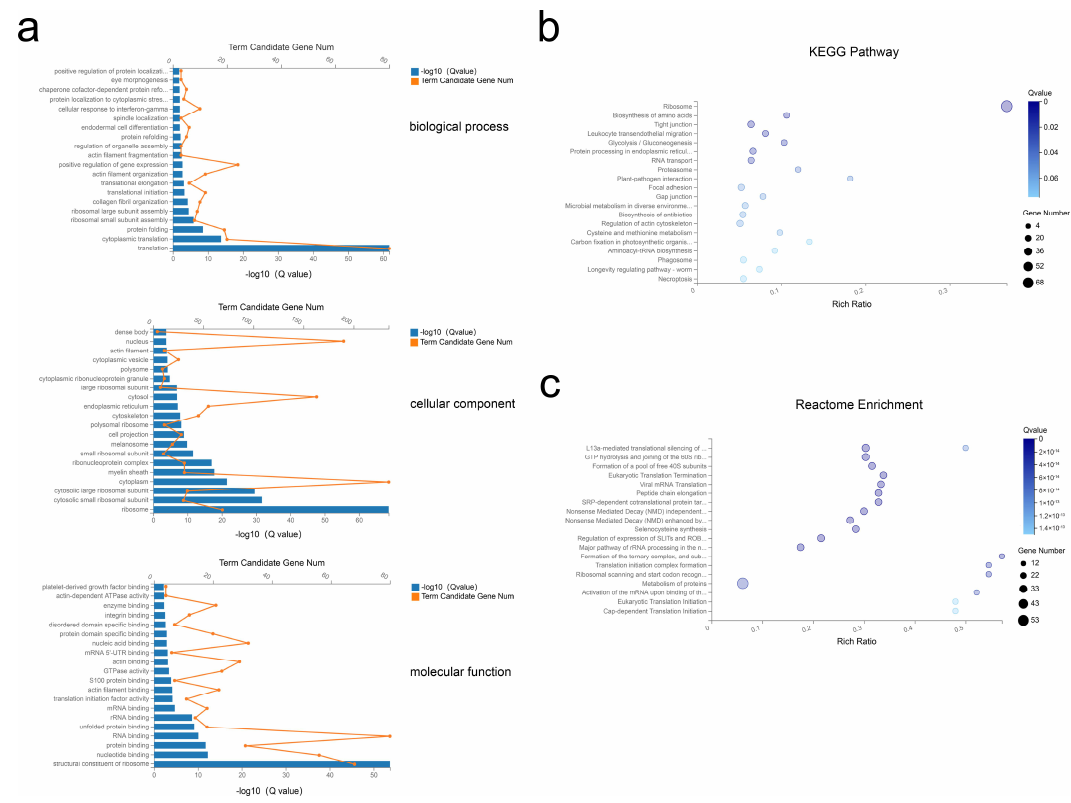
Figure 4. GO, KEGG, and reactome enrichment analysis of exosomal mRNAs. ( a ) The 20 most enriched GO terms including biological process, cellular component, and molecular function. ( b , c ) Advanced bubble chart of KEGG pathway annotation ( b ) and reactome enrichment analysis ( c ) with 20 highest enrichment